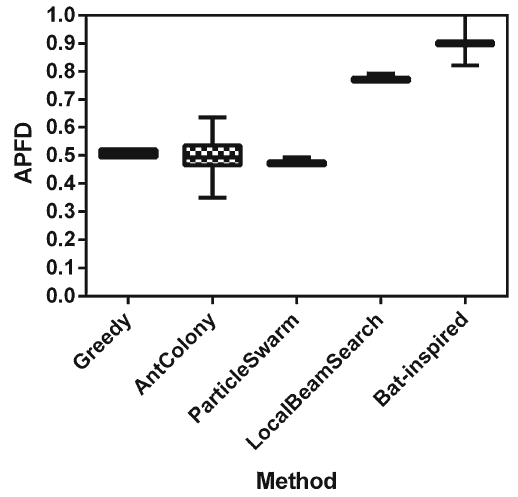
Fig. 2 Mean APFD box plots of all algorithms on all data sets